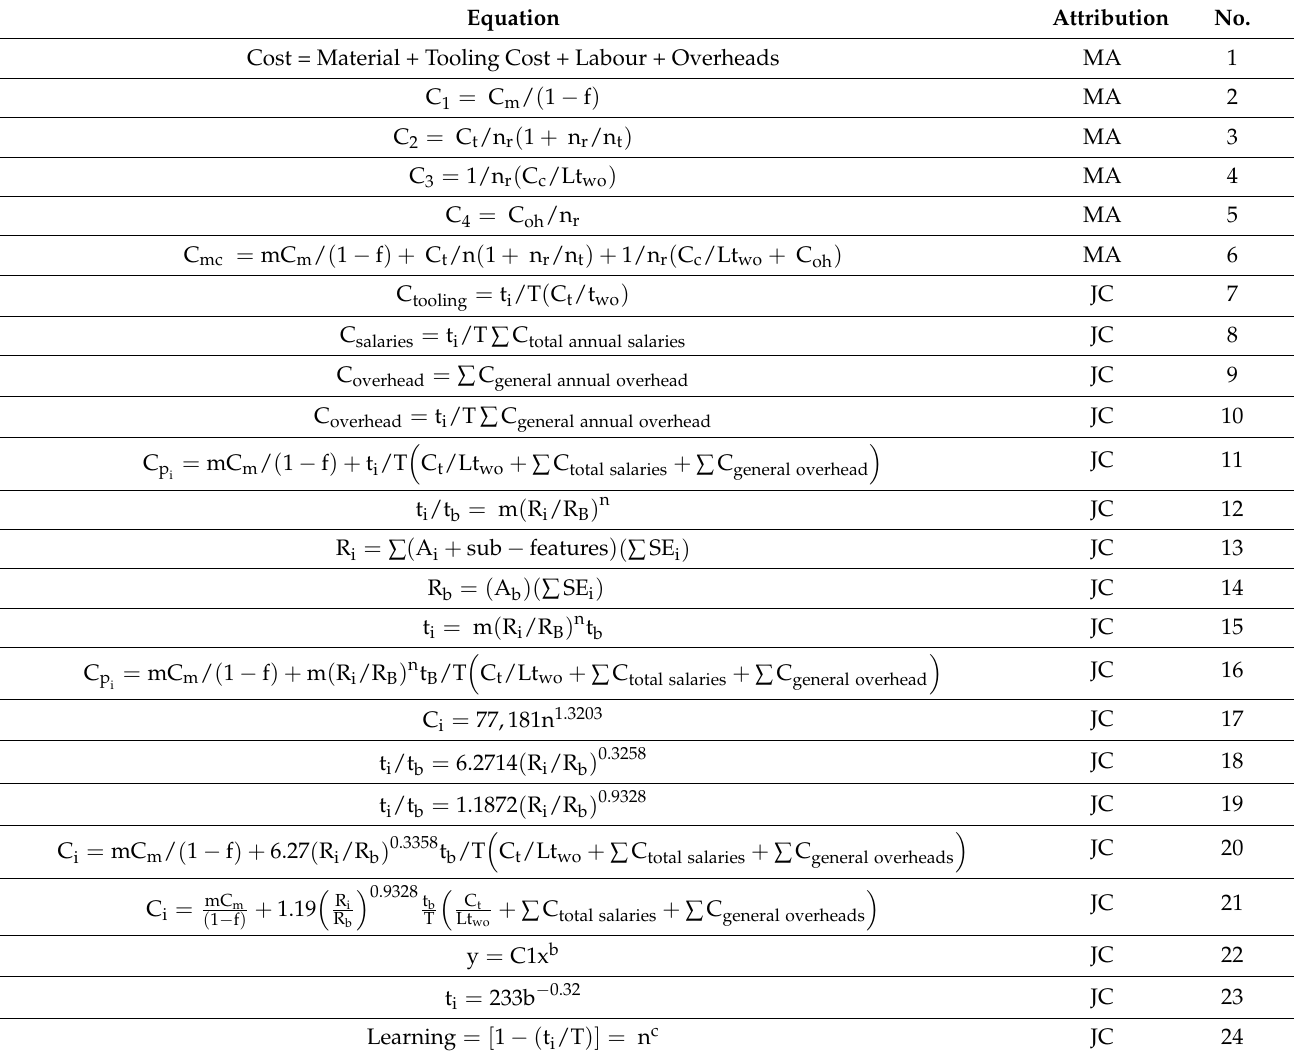
Table 13. Equation